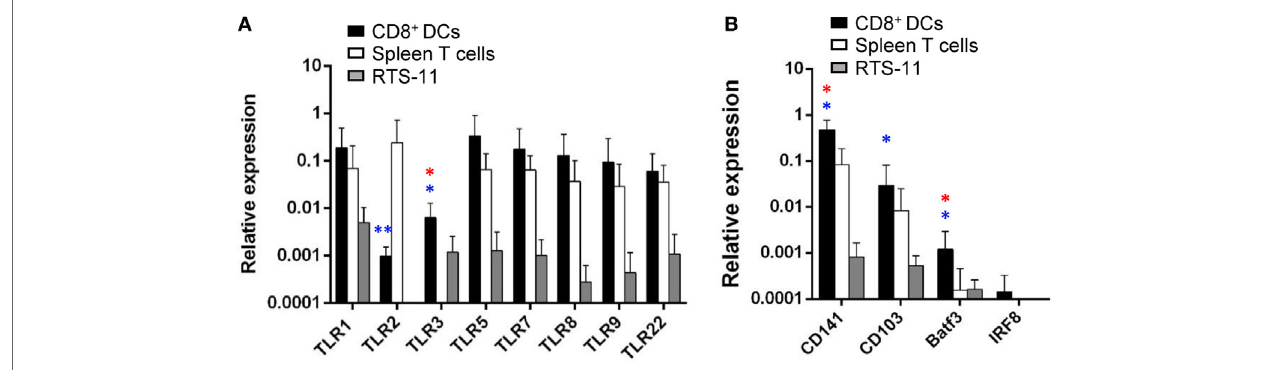
FigUre 5 | Transcription of toll-like receptor (TLR) genes and markers of mammalian cross-presenting dendritic cells (DCs) on gill CD8 + DCs. CD8 + DCs and splenic CD8 + T cells were isolated by flow cytometry, and RNA obtained. RNA was also obtained from the RTS11 monocyte–macrophage cell line. These RNAs were used to study the levels of transcription of the different TLRs (a) and other markers of cross-presenting DCs (B) by real-time PCR. Relative expression levels of the indicated genes to the endogenous control elongation factor 1 α were calculated for each sample value (mean + SD; n = 3–7). Asterisks in red indicate significant differences between values obtained in gill CD8 + DCs and splenic CD8 + T cells, whereas asterisks in blue denote significant differences between values obtained in gill CD8 + DCs and RTS11 cells (* p ≤ 0.05 and ** p ≤ 0.01).